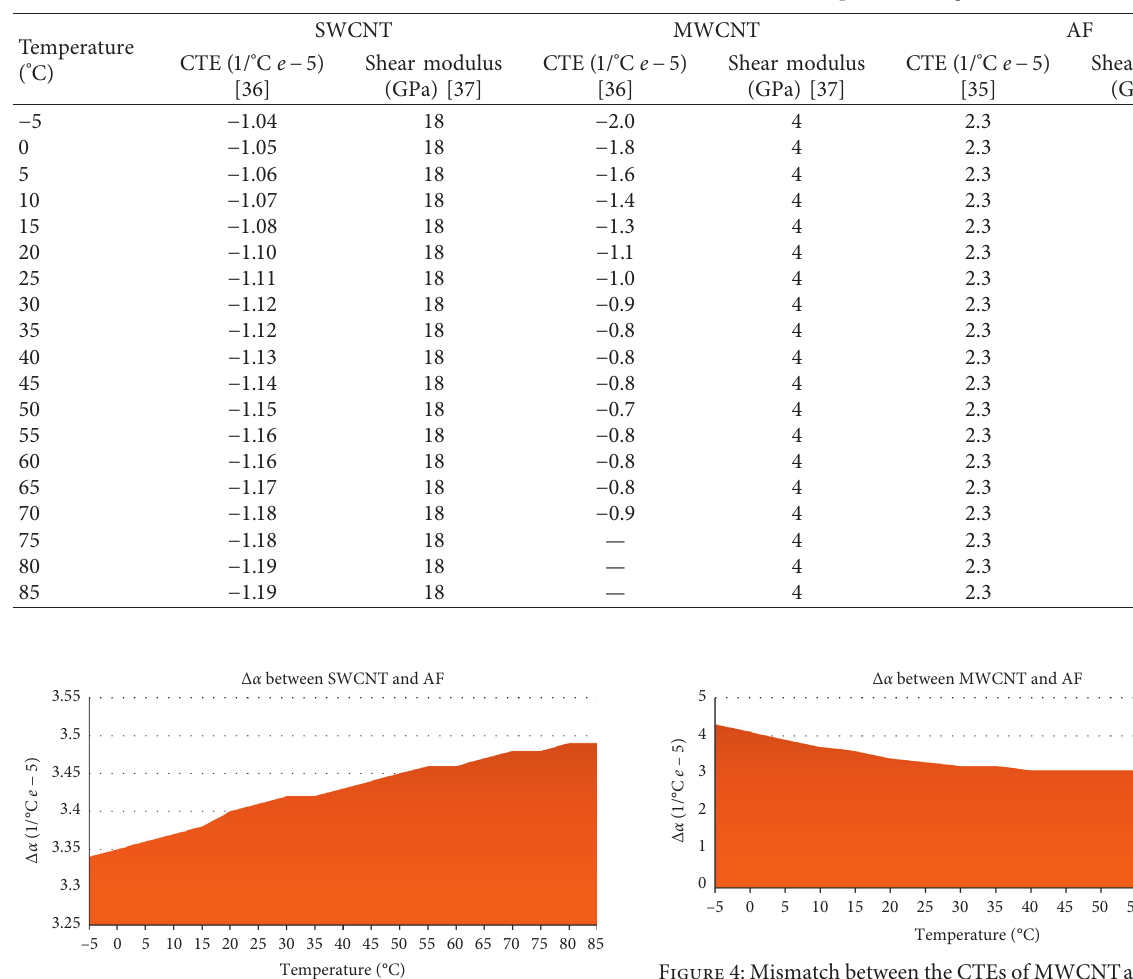
Table 4: CTEs and shear modulus of SWCNT, MWCNT, and AF at temperature range of − 5 to 85 ° C.